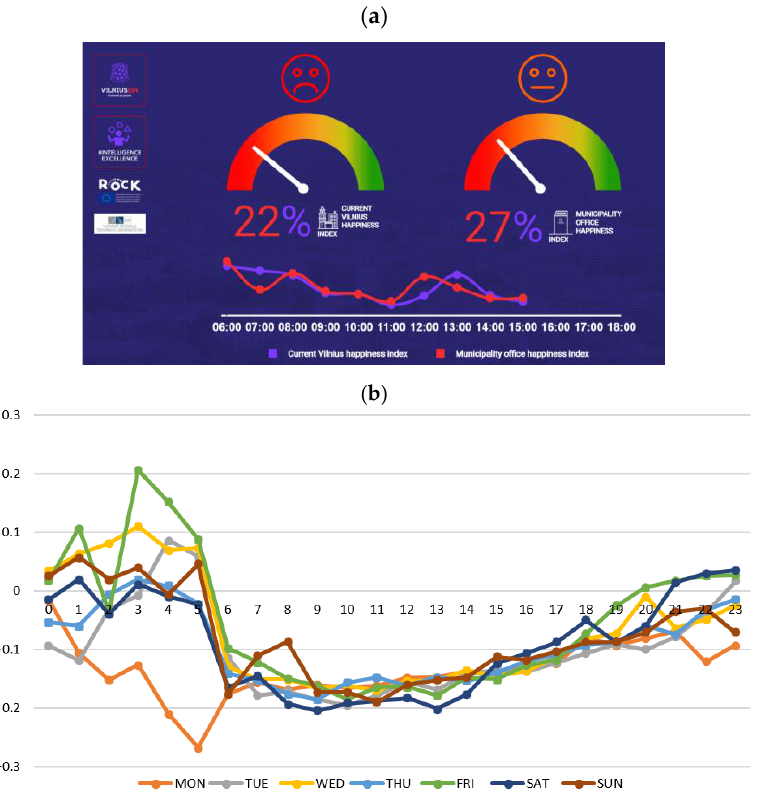
Figure 10. Real-time Vilnius Happiness Index (a) and the mean magnitudes of valence, by the hour, on weekdays (b) .